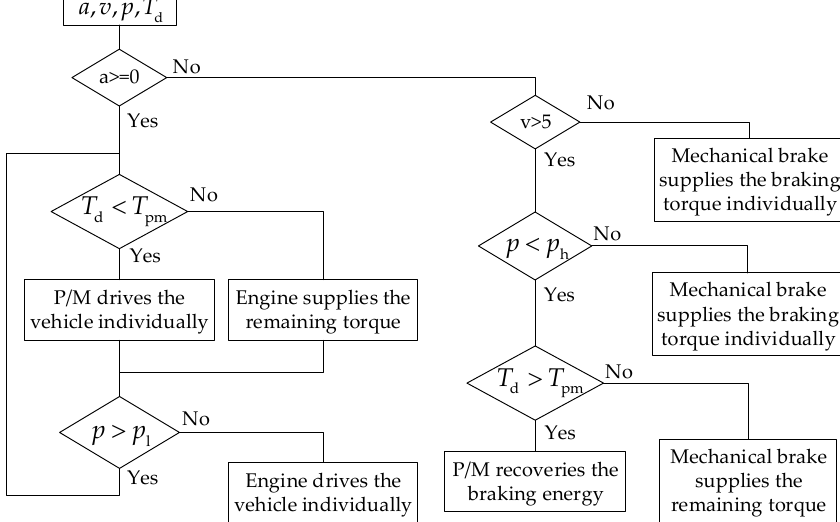
Figure 9. Power management strategy of the HHV.